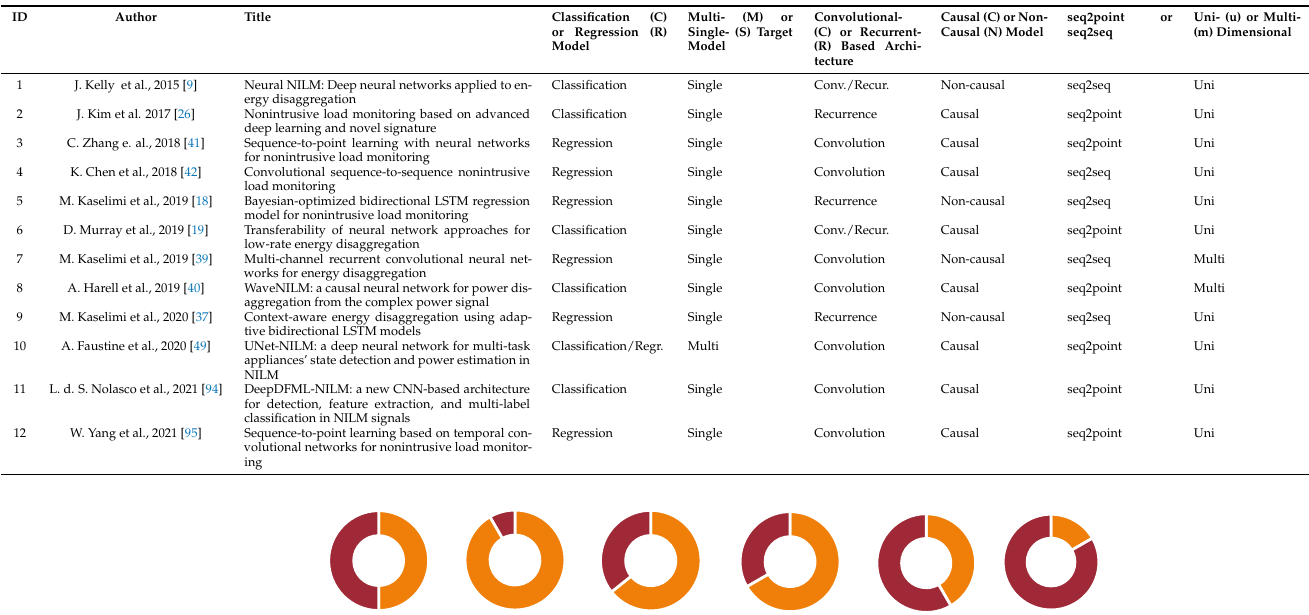
Table 1. List of the representative works that target all research dilemmas and the choices the researchers finally made. Only supervised learning techniques address all dilemmas and, thus, are listed in this table.